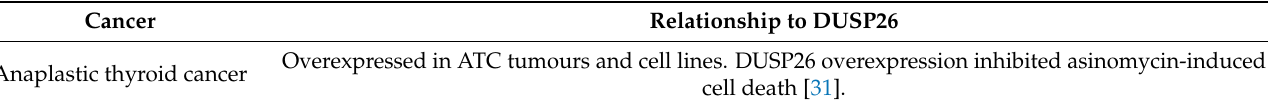
Table 2. Tumour-suppressive and -promoting roles of DUSP26 in